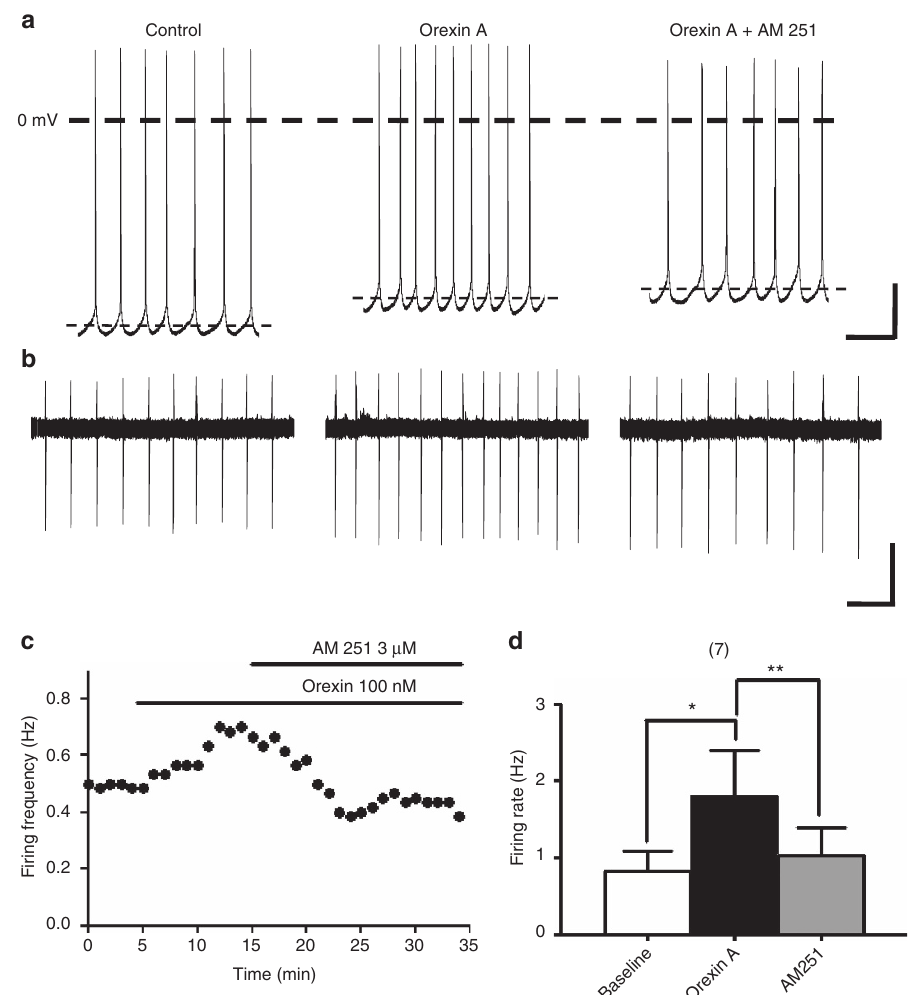
Figure 5 | Orexin A increased the firing rate of VTA dopaminergic neurons through CB1Rs. ( a , b ) The firing activity in a representative neuron recorded in the ( a ) whole cell or ( b ) cell-attached recording mode before and 10min after treatment with 100nM orexin A, and 10min after further treatment with 3 m M AM 251. Scale bars, ( a ) 500ms and 20mV; ( b ) 5s and 20pA. ( c ) The time course of the effect of orexin A before and after further treatment with AM 251 on the firing rate of a representative neuron recorded by cell-attached mode. ( d ) Effects of orexin A alone or in combination with AM 251 on the average firing rate of VTA dopaminergic neurons. Neuronal firing activity was assessed in the whole cell and cell-attached recording mode. Note that 100nM orexin A (black bar) significantly increased the average firing rate of VTA dopaminergic neurons, compared with baseline firing rate (open bar) and this effect was reversed by 3 m M AM 251 (gray). n ¼ 7, * P o 0.05, ** P o 0.01 (repeat measures one-way ANOVA with Dunns post hoc test). Data are expressed